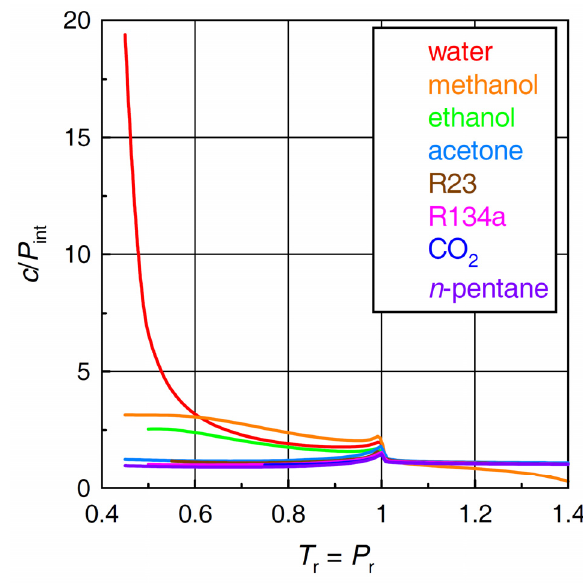
Figure 4. Cohesive energy density/internal pressure ratios c / P int of the selected fluids.